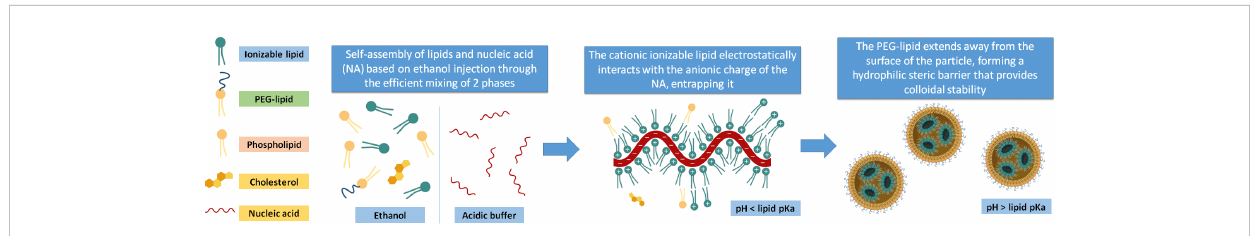
FIGURE 1 Main components of the iLNPs. The lipid components are dissolved in an ethanolic phase, and the nucleic acid is in an acidic buffer. When these two phases are ef fi ciently mixed, the ionizable lipid gets protonated and electrostatically interacts with the anionic charges of the nucleic acids while the rest of the lipids self-assemble to form the iLNP structure. When the formation is complete, the pH of the batch can be brought to a value higher than the ionizable lipid